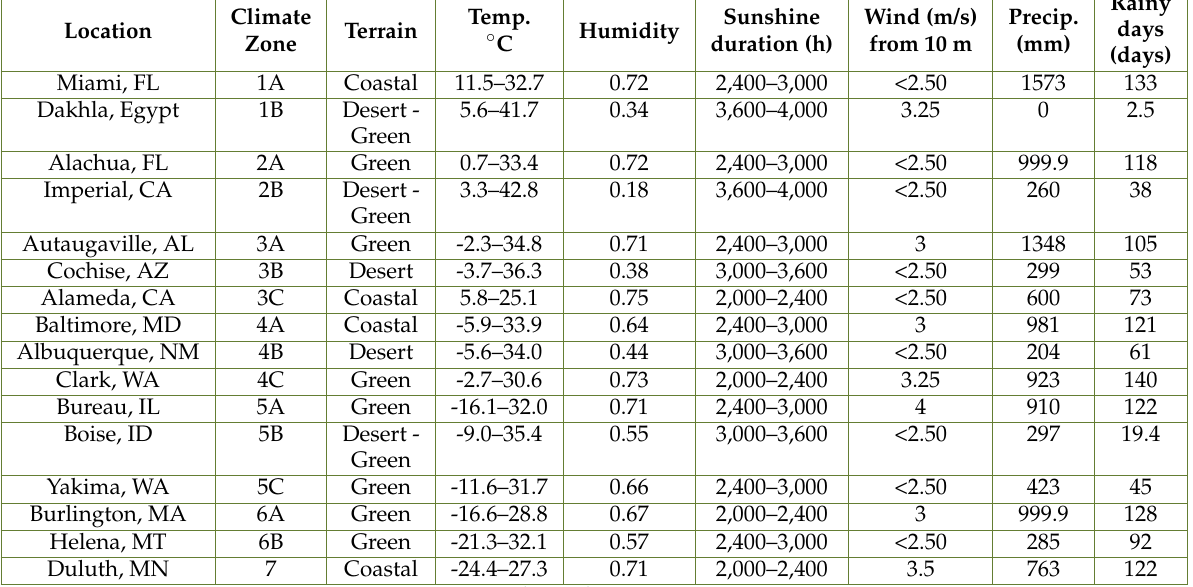
Table 1. Location and climate zone data